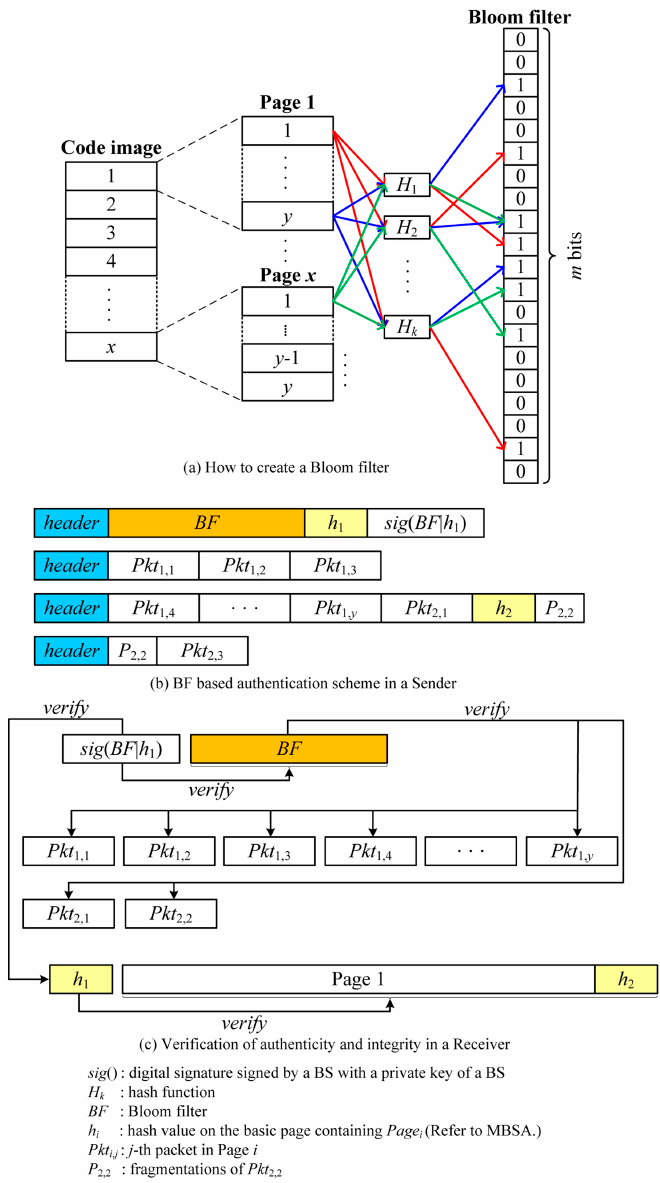
Figure 7. An example of BFBSA.